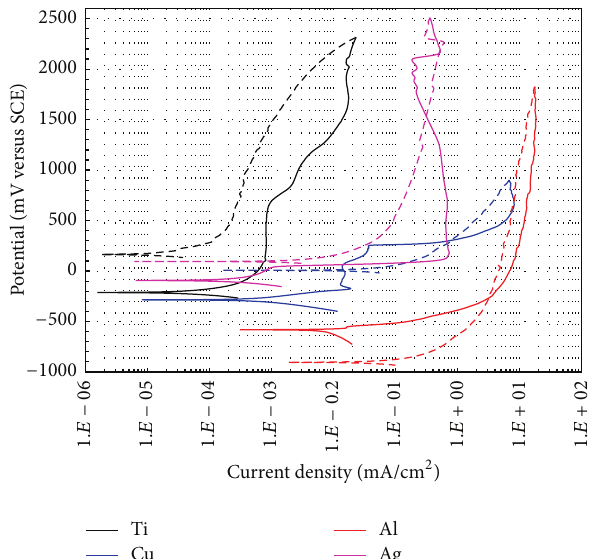
Figure 3: Cyclic polarization curves for pure elements (Ti, Cu, Al, and Ag) in artificial saliva at 37 ∘ C (d 𝐸 /d 𝑡 = 0.167 mV/s).